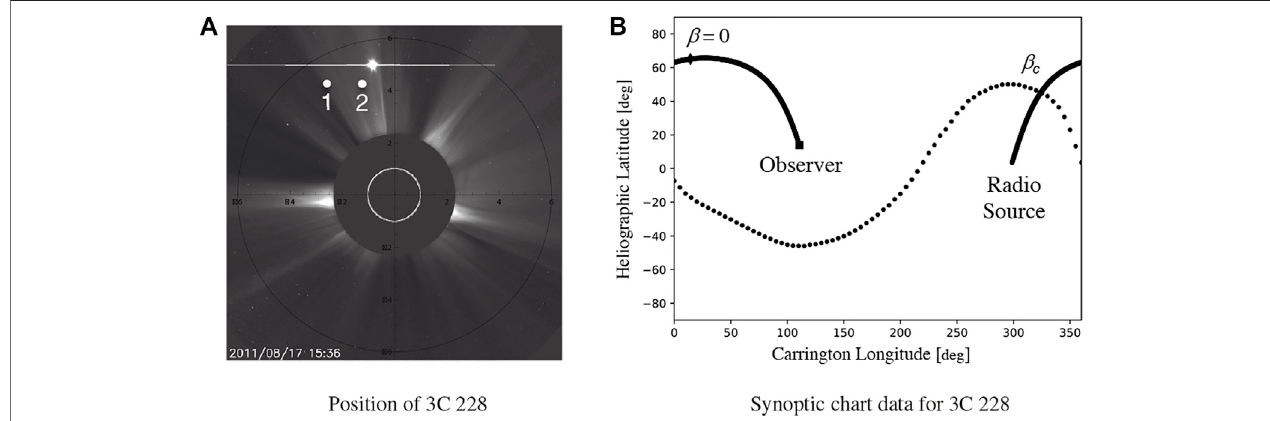
FIGURE 2 | Position of radio galaxy 3C 228 during coronal FR observations on 2011 August 17 reported in Kooi et al. (2014) (A) and the LOS to 3C 228 mapped onto synoptic chart data to calculate β c (B) . Positions of 3C 228 near the beginning ( “ 1 ” ) and end ( “ 2 ” ) of the 8-h observations are plotted on a LASCO-C2 coronagraph image, along with a white circle to represent the Sun ’ s position. The bright source north of the LOS is Venus. In the right panel, the solid line is the projected LOS to 3C 228inheliographiclatitudeand Carrington longitude.Dotted linegivesthelocationofthemagnetic neutrallineasdetermined bytheWSO radialmodelwithsource surface at 3.25 R ⊙ . The solid square is the heliographic projection of the observer (Earth, β =180 ° ), the solid diamond gives the midpoint of the LOS ( β =0 ° ), and β c is measuredwheretheLOSandneutrallineintersect( − 33 ° ).LeftimageappearsasFigure3inKooietal.(2014)andispubliclyavailableathttps://sohowww.nascom.nasa. gov/. Right image appears as Figure 11 in Kooi and Kaplan (2020), ©Springer, reproduced with